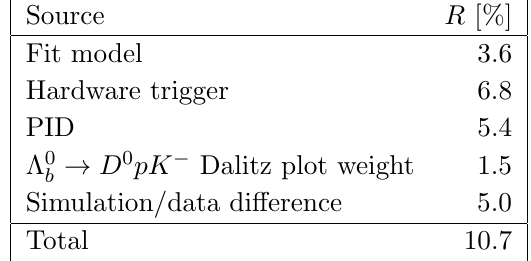
Table 2 . Summary of the systematic uncertainties on measurement of the production ratio, R